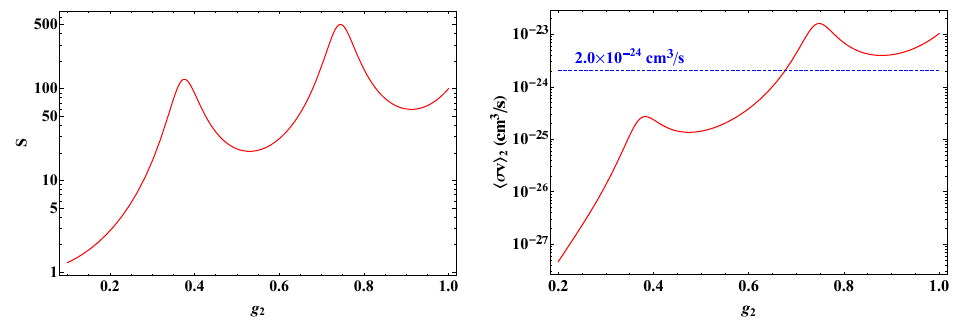
Figure 15 . Left panel: Sommerfeld enhancement factor S as a function of the coupling g 2 where m (cid:31) = 1 : 5 TeV and m V = 10 GeV. Right panel: DM annihilation cross section h (cid:27)v i 2 as a function 2 of g 2 . The blue-dashed line indicates the needed cross section to (cid:12)t DAMPE